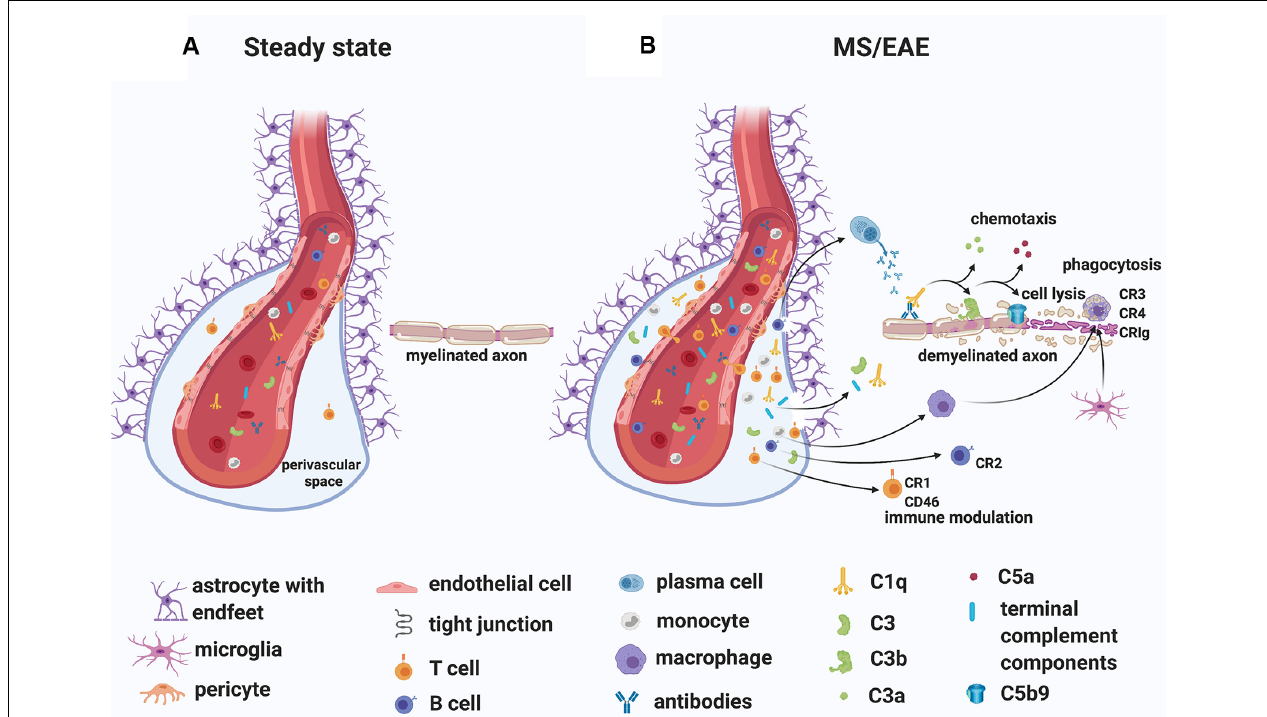
FIGURE 4 | A role for complement in the “outside-in” paradigm of white matter demyelination in MS. (A) During steady state, complement components circulate in the blood. Only leukocyte extravasation across the blood-brain barrier (BBB) occurs but is limited to few activated CD4 + T lymphocytes that perform immunological surveillance. These activated lymphocytes interact with adhesion molecules (ICAM-1, VCAM-1) expressed on the lumen of vascular endothelial cells. Chemokine (CXCL12) expression by endothelial cells on the abluminal side contributes to sequestering the activated CD4 + T cells in the perivascular space through binding to the chemokine receptor (CXCR4) on the T cell. (B) During MS/EAE, the efficiency of leukocyte diapedesis is increased. CCL19, CCL21, and CXCL12 are up-regulated by cerebrovascular endothelial cells that promote the recruitment and adhesion of CD4 + T cells primed in the periphery against a CNS antigen. On the abluminal surface of endothelial cells, CXCR7 binds to CXCL12 to reduce T cell sequestration in the perivascular space. Within the perivascular space, activated T cells produce chemokines and cytokines (such as TNF α and GM-CSF) that promote the recruitment of myeloid cells from the blood. Matrix metalloproteinases (MMP-2 and MMP-9) are produced and selectively cleave dystroglycan in the astrocytic foot processes, allowing penetration of T cells, B cells, monocytes, and complement into the CNS parenchyma. Within the CNS, encephalitogenic T cells re-encounter their specific antigen and are re-activated, producing inflammatory cytokines. T cells can also bind directly to myelin epitopes producing cytotoxic mediators and leading to activation of macrophages. Infiltrating B cells transition into antibody-producing plasma cells perhaps in situ . Autoantibodies can also enter the CNS through a breached BBB. Complement components enter the CNS via a breached BBB and are activated either by the recognition of antigen/antibody complexes or directly by “altered self” myelin epitopes. Complement-tagged myelin is then phagocytosed by phagocytes expressing complement receptors (macrophages and microglia). Activated complement components can also bind T cells and B cells via their complement receptor modulating their function (see details in text). Abbreviations: CNS, central nervous system; TNF α , tumor necrosis factor α ; GM-CSF, granulocyte-macrophage colony-stimulating factor; CR, complement receptor.